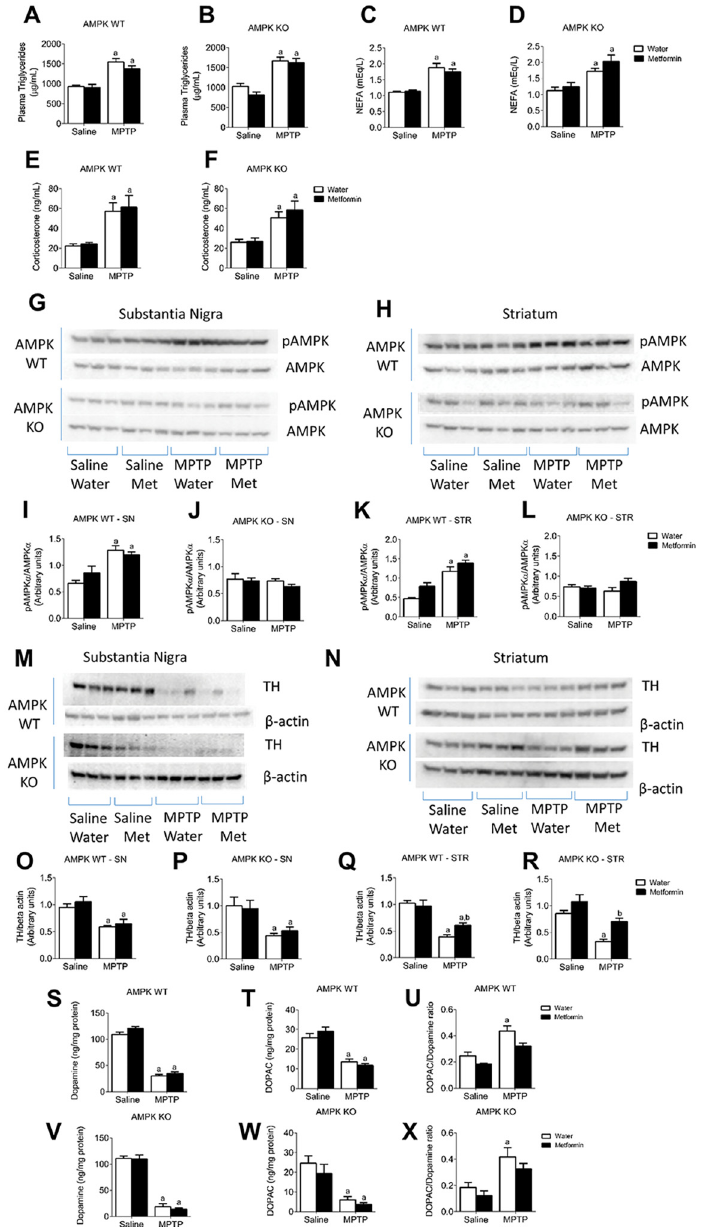
Fig 2. Metformin is neuroprotective in AMPK WT and KO mice. Plasma Triglycerides ( A & B ), NEFA ( C & D ) and corticosterone ( E & F ) are elevated in response to MPTP. Representative Western Blot images of pAMPK/AMPK in the SN ( G ) and Striatum ( H ). Protein analysis of the pAMPK/AMPK ratio showing no elevation in response to MPTP in the SN ( J ) and Striatum ( L ) in AMPK KO but an elevation in both the SN and Striatum of AMPK WT mice ( I & K ). Representative images of TH levels in the SN ( M ) and Striatum ( N ). In the SN there is a significant reduction in TH levels in both AMPK WT ( O ) and KO ( P ) in response to MPTP. In the Striatum Metformin elicits a neuroprotective effect in MPTP treated AMPK WT ( Q ) and KO ( R ) mice. MPTP reduced dopamine and DOPAC in both AMPK WT ( S & T ) and AMPK KO ( V & W ) mice. Metformin reduced the elevation of the DOPAC:DA ratio in MPTP treated mice compared to water alone, in AMPK WT and KO mice ( U & X ) a, significant compared to water/saline treated mice and b, significant compared to water/MPTP treated mice. Data are represented as mean ± SEM (n = 6 – 9, two-way ANOVA, p < 0.05).